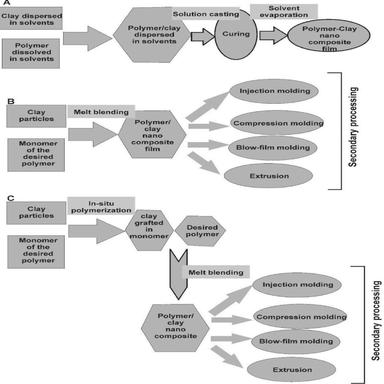
Preparation techniques of polymer-clay nanocomposites.